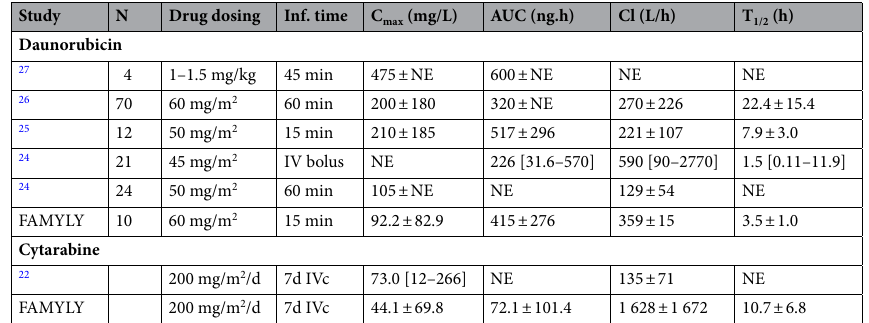
Table 4. Pharmacokinetics of daunorubicin and cytarabine of the FAMYLY study compared to those of previous studies. Numbers between brackets indicate [min–max] when the S.D. is absent. Inf infusion, IV intravenous, IVc IV as a continuous infusion, NE not